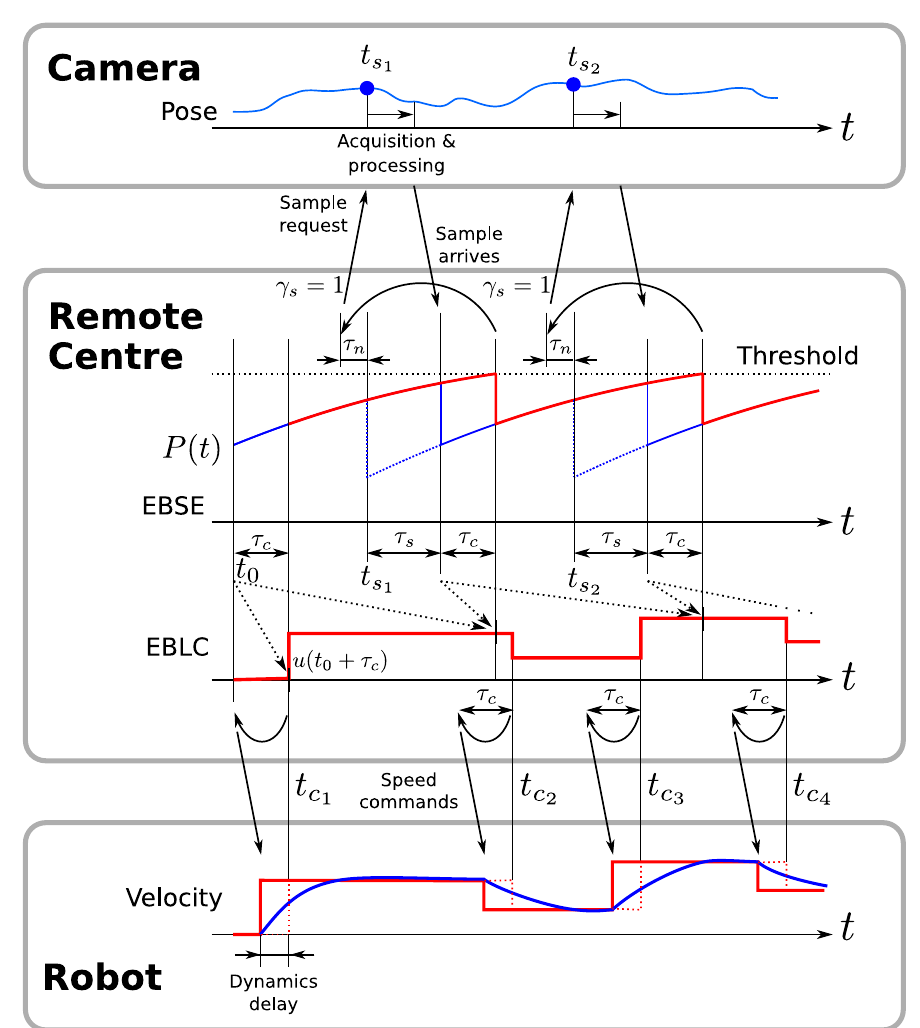
Figure 4. Diagram showing communications between the remote centre, sensor and robot, explaining the strategy to compensate for